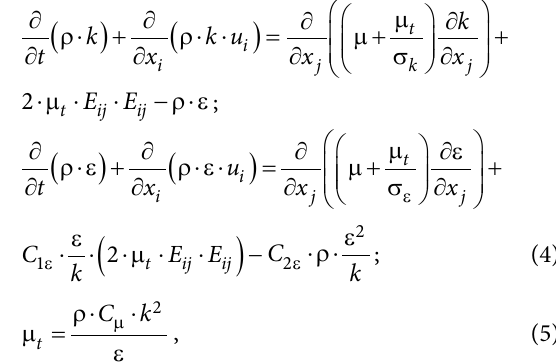
Table 2. Pressure drop at different fitting connections with reference to pre-experimental research Fitting standard Pressure drop [Pa] BSP JIS DKOL ORFS